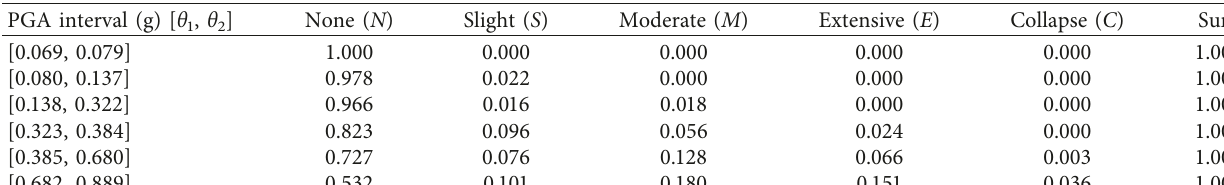
Table 3: Degree of belief m based on the fraction of each damage state in PGA intervals.